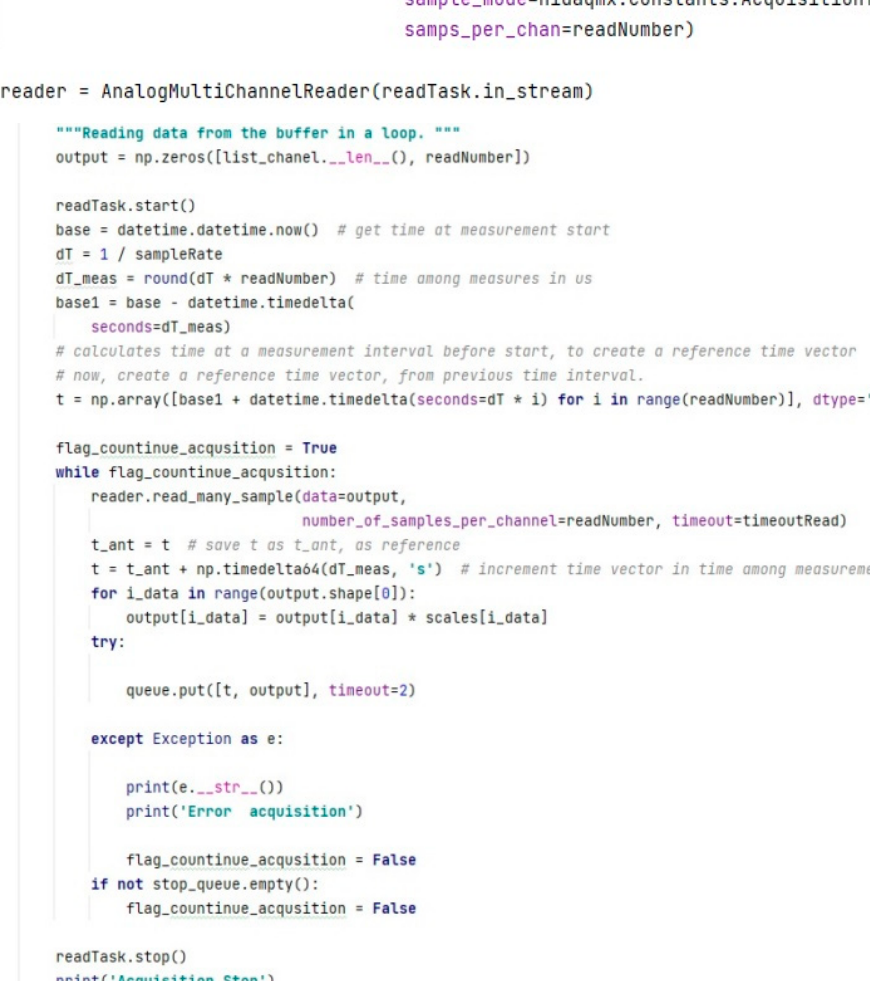
Figure 5. The Python code associated with data acquisition project.